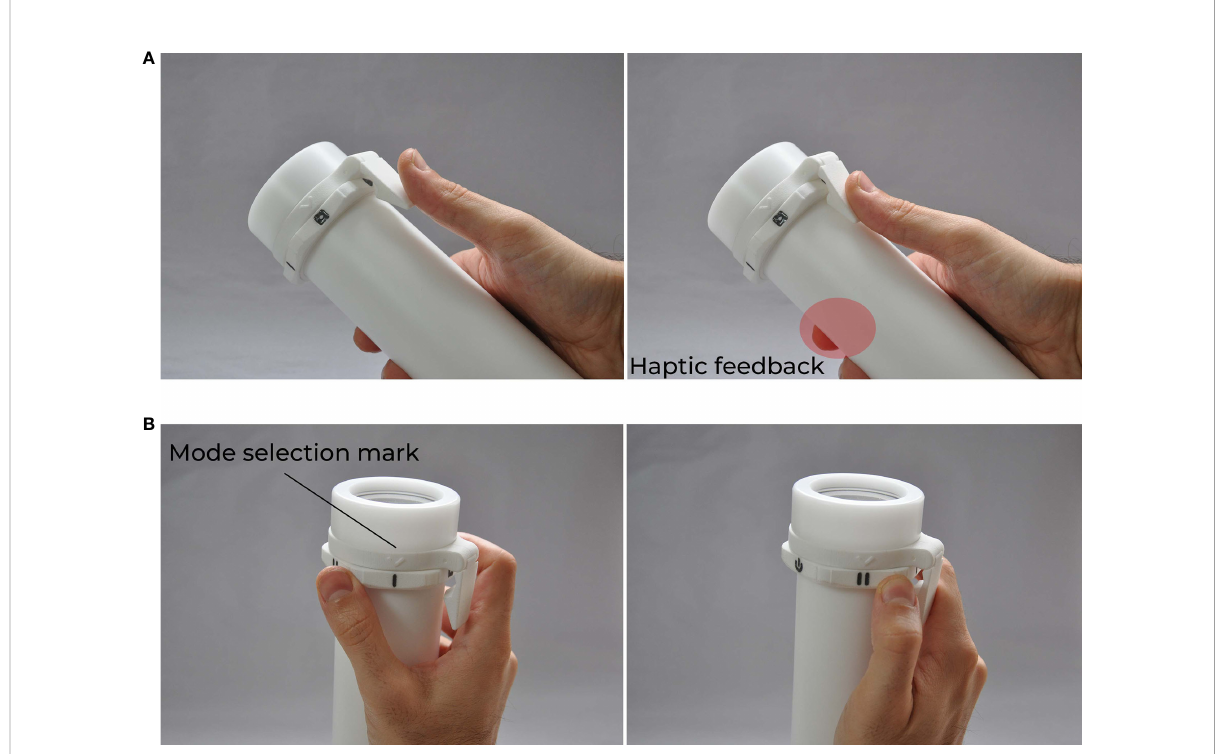
FIGURE 3 (A) The push button is used for speci fi c operations, such as starting and stopping video capture, or taking a still image. These actions also initiate haptic feedback which can be felt by a user holding the unit. (B) The control ring can be operated with one hand to select modes. Current mode is indicated by the mode selection mark.